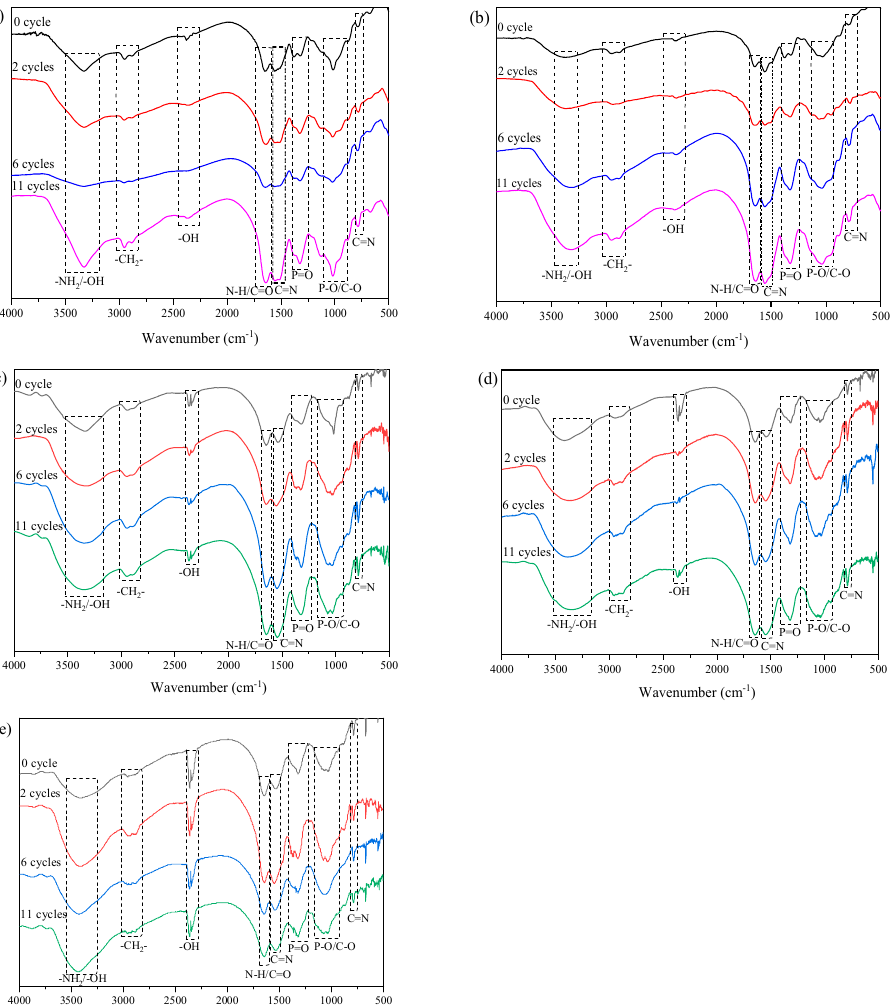
Figure 12. FTIR spectra of the transparent fire-retardant coatings recorded at different accelerated ageing cycles: ( a ) MPPB0, ( b ) MPPB1, ( c ) MPPB2, ( d ) MPPB3 and ( e ) MPPB4. Table 6. The FTIR functional groups of the MPPBs coatings after accelerated ageing treatment.